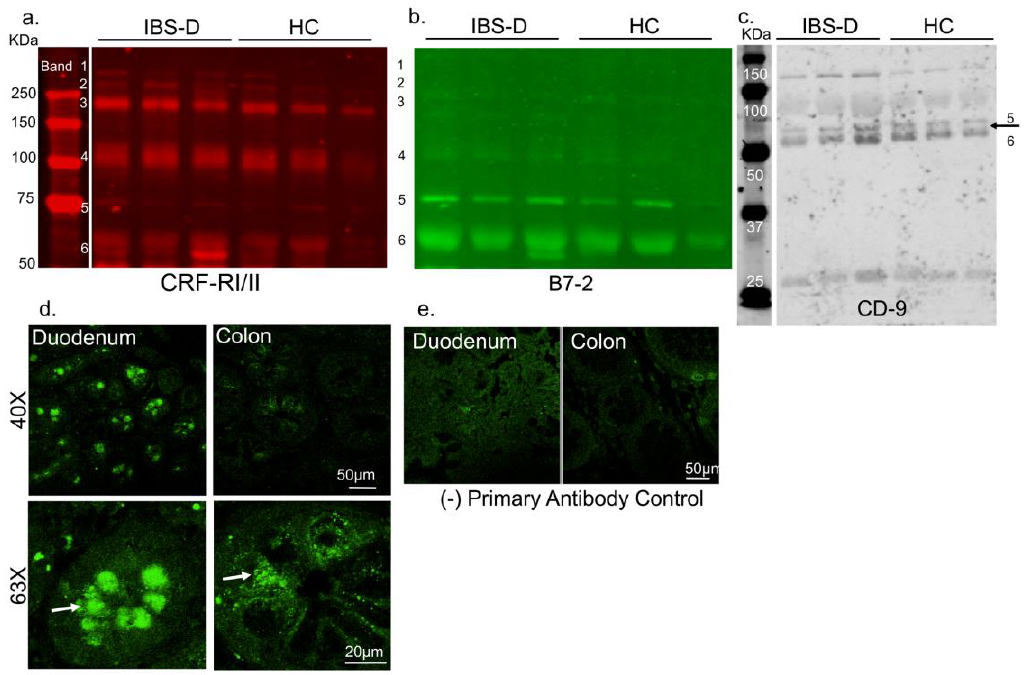
Figure 1. CRF receptors in human plasma, EVs, and human gut. ( a ) Representative immunoblots showing presence of CRF receptors 1 and 2, B7-2, and CD9 bands in plasma of healthy human subjects and IBS-D patients. Band 5 and 6 of CRFR overlapped with bands in ( b ) B7-2, and ( c ) CD9 immunoblots. IBS-D: irritable bowel syndrome patients with diarrhea; HC: healthy controls. ( d ) Representative confocal micrographs showing localization of CRFR granules in human duodenal and colonic biopsies. Intestinal crypts with CRFR immunoreactivity in goblet cells (arrows) at 40 × and 63 × magnification are shown. Scale: 50 µ m at 40 × and 20 µ m at 63 × . ( e ) Representative images of negative controls. Primary antibody for CRF-RI/II was excluded, but all other steps were performed in parallel with other sections shown in 1d.